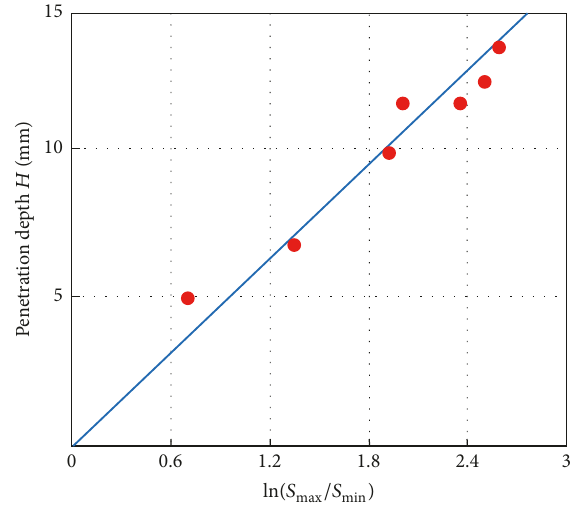
Figure 13: Experimental dependence between the depth of pene- tration and the secondary waveform parameter ln (𝑆 max /𝑆 min ) given welding with oscillation along the joint and different focus settings ( 𝑃 = 3 kW, oscillation frequency 𝑓 = 678 Hz, and sweep size 2𝐴 = 1.3 mm) [24].